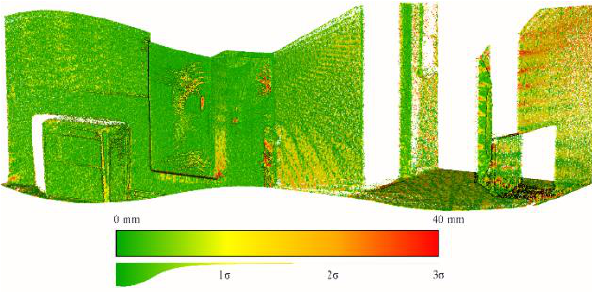
Figure 8: Cloud-to-cloud distances for the Livox and Velodyne LiDAR after the 6D relative pose estimation.